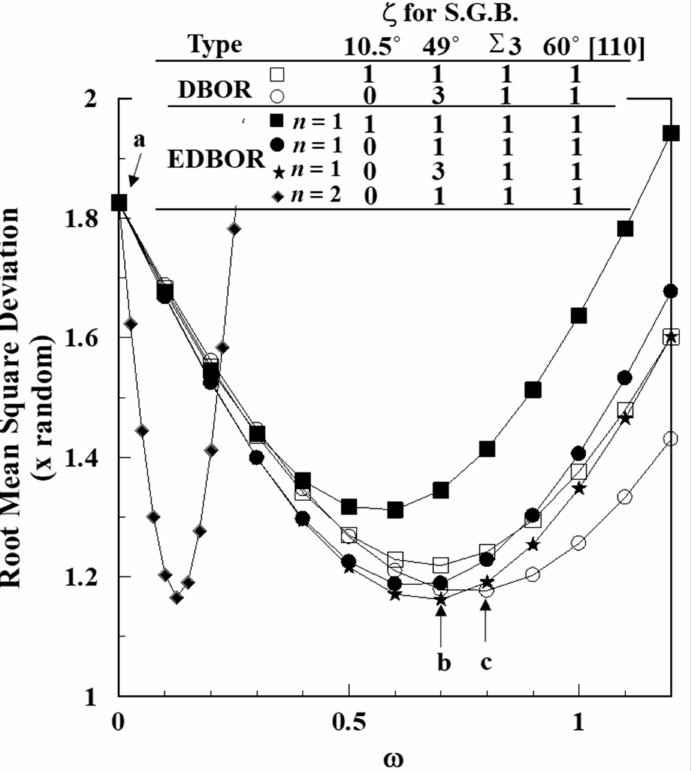
Figure 8. Change in root mean square deviation between observed and prediction ODFs by changing ω and ζ for β → α -hex transformation. See inset table for calculation conditions.